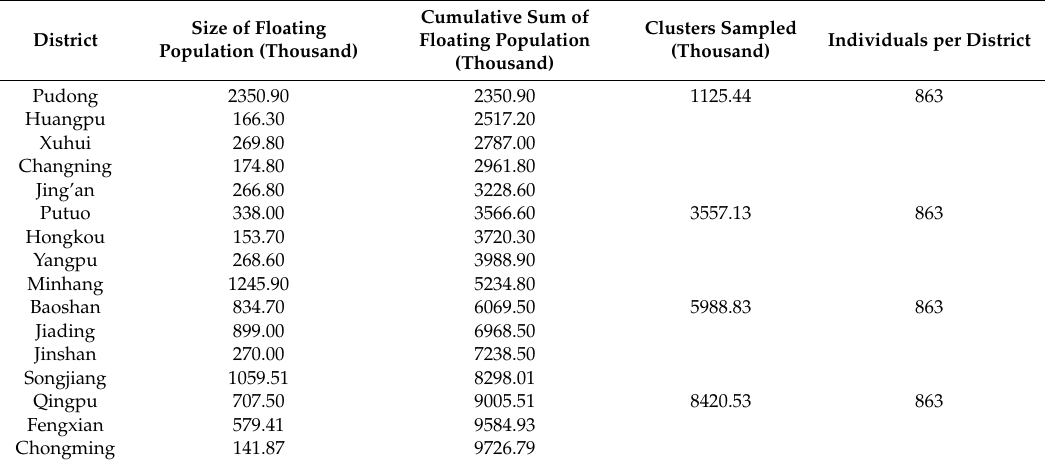
Table 2. PPS sampling of PSU for floating